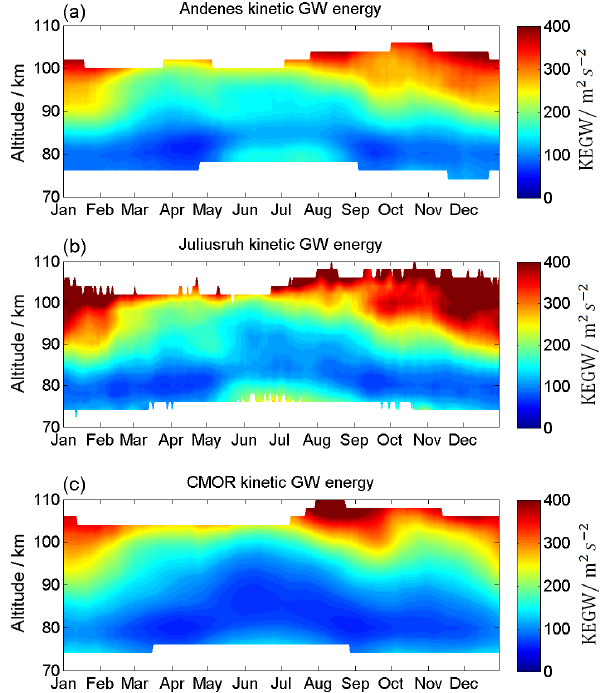
Figure 17. Composite of kinetic gravity wave energy for An- denes (a) , Juliusruh (b) , and CMOR (c) .